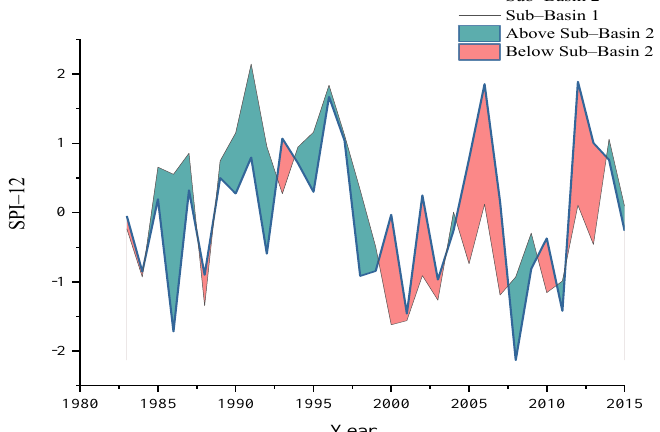
Figure 3. Difference in meteorological drought (SPI–12) severity at both sub-basins representing the spatial variations across the Soan river basins.